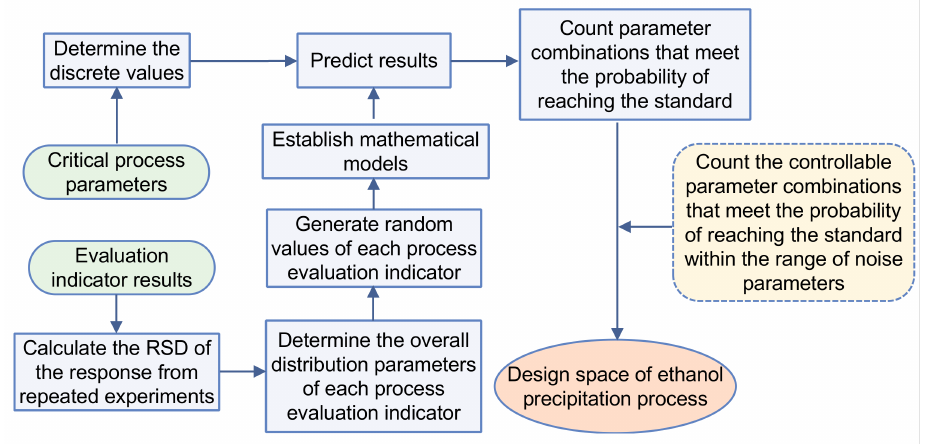
Figure 2. Design space calculation process when considering a noise parameter.